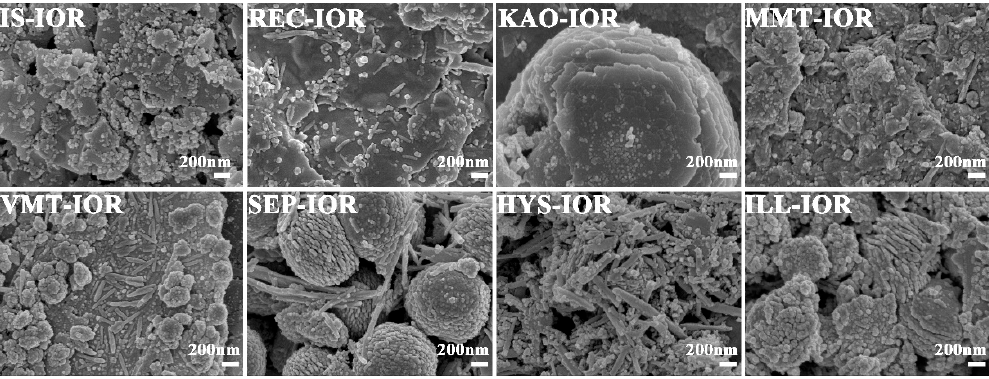
Figure 3. SEM images of IS-IOR, REC-IOR, KAO-IOR, MMT-IOR, VMT-IOR, SEP-IOR, HYS-IOR, and ILL-IOR.